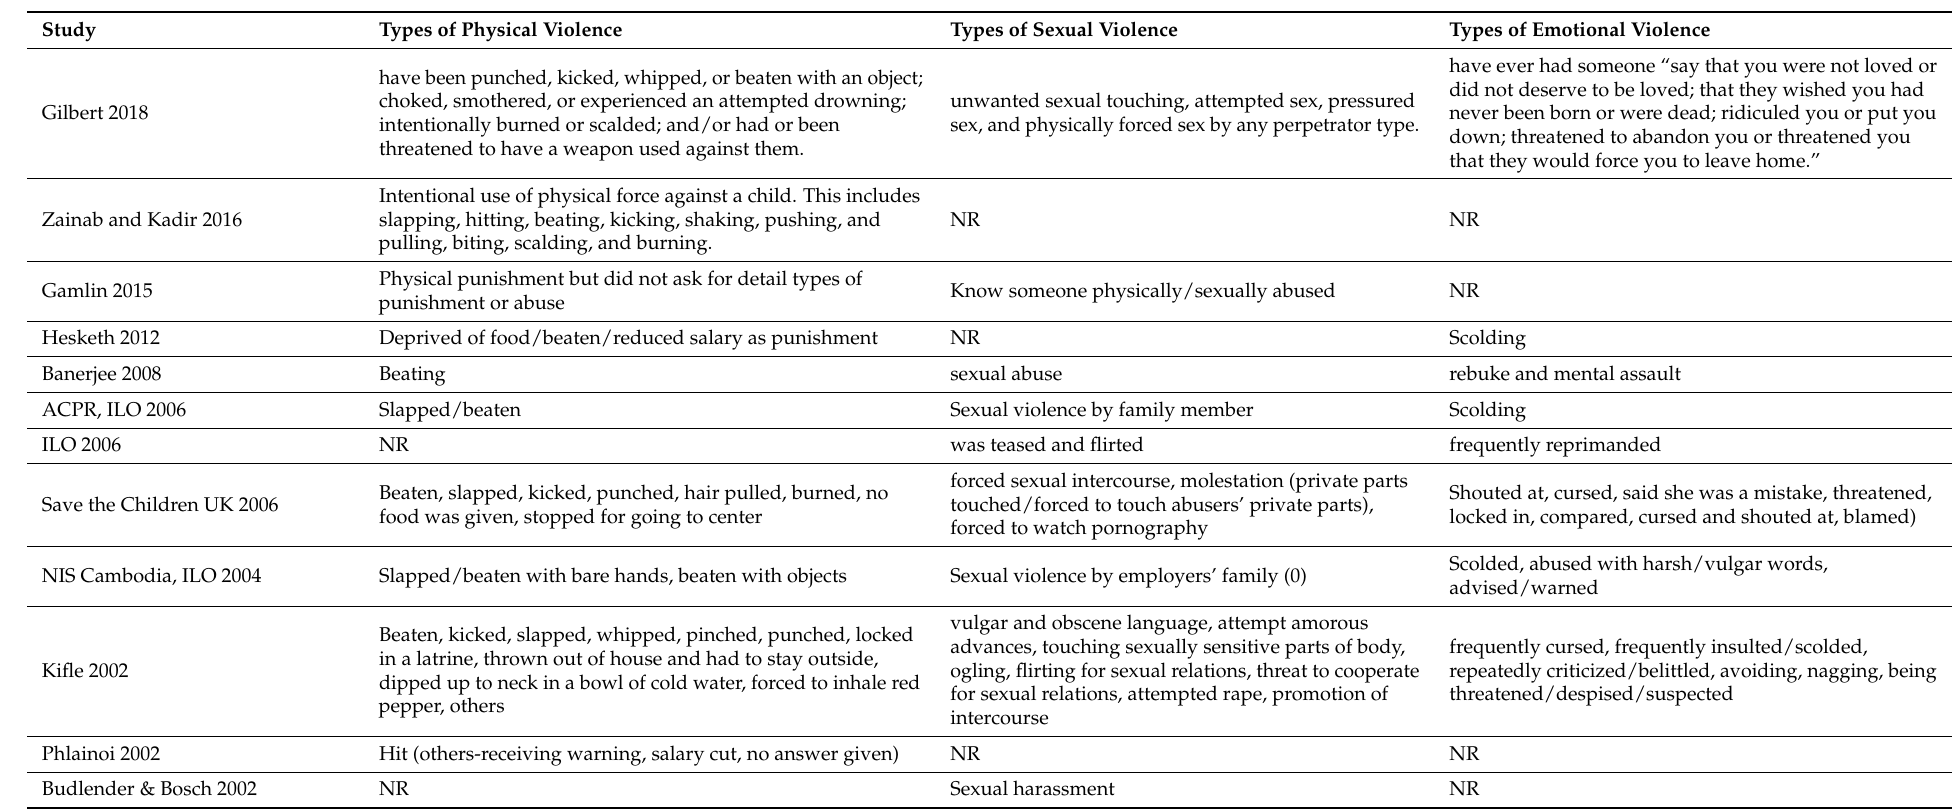
Table A3. Operational definitions of physical, sexual, and emotional violence ( n =